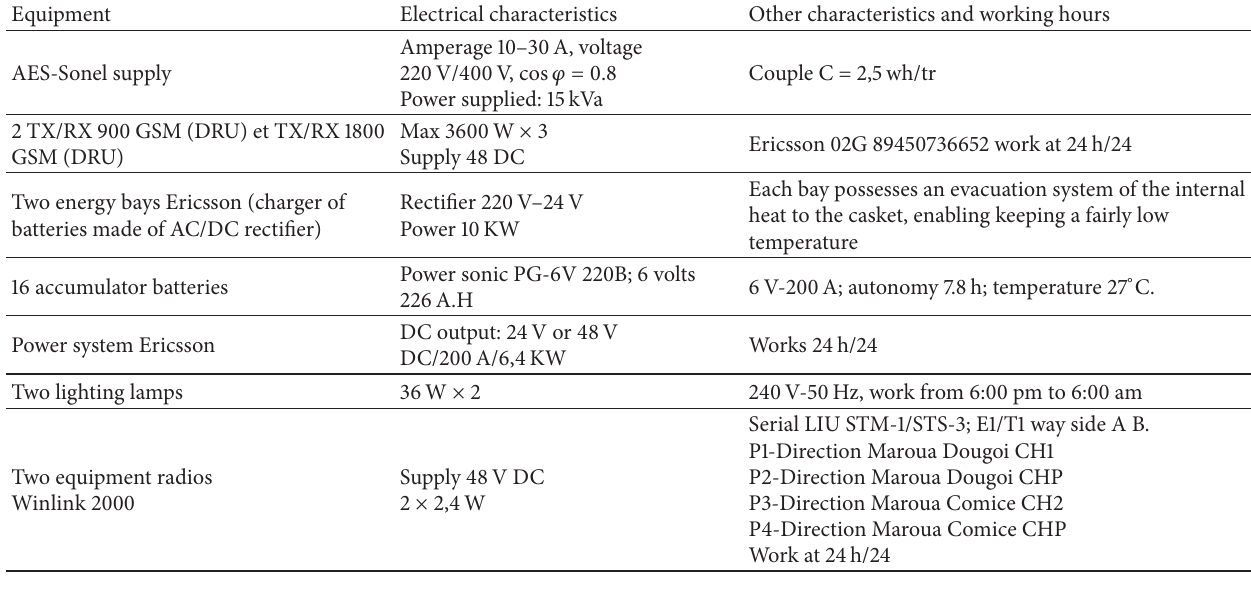
Table 5: Equipment of the MTN Maroua Market site.